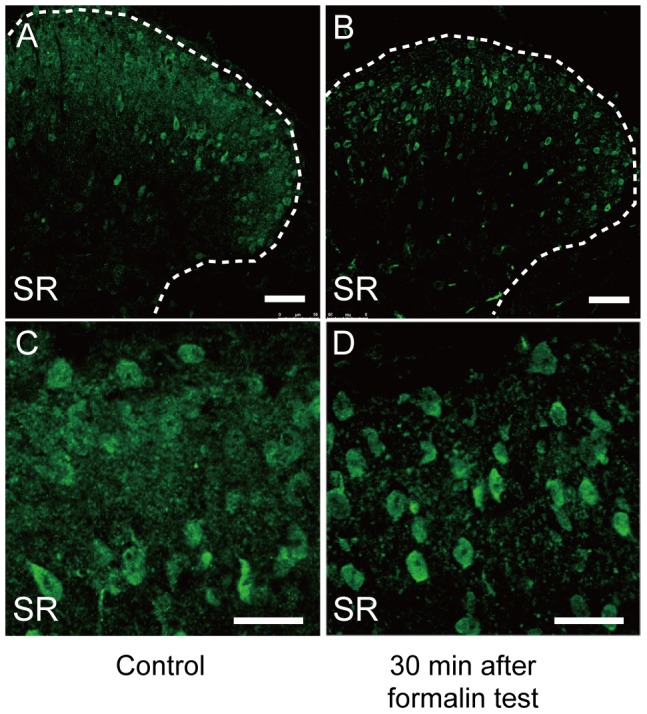
The distribution of SR in the dorsal horn changed after the formalin test.(A, C) Before the formalin injection, SR (green) was uniformly distributed in lamina II of the dorsal horn of the lumbar spinal cord in the WT mice. An enlarged image of lamina II demonstrates a relatively dense distribution of SR signals particularly in cell bodies. Bars indicate 50 µm. (B, D) Thirty minutes after the formalin test, the density of immunofluorescence SR signals in the ipsilateral dorsal horn decreased. A magnified image of lamina II revealed that the signals of SR concentrated in cell bodies (D). Bars indicate 50 µm. Dotted lines in A and B are the outline of the gray matter of the spinal cord.